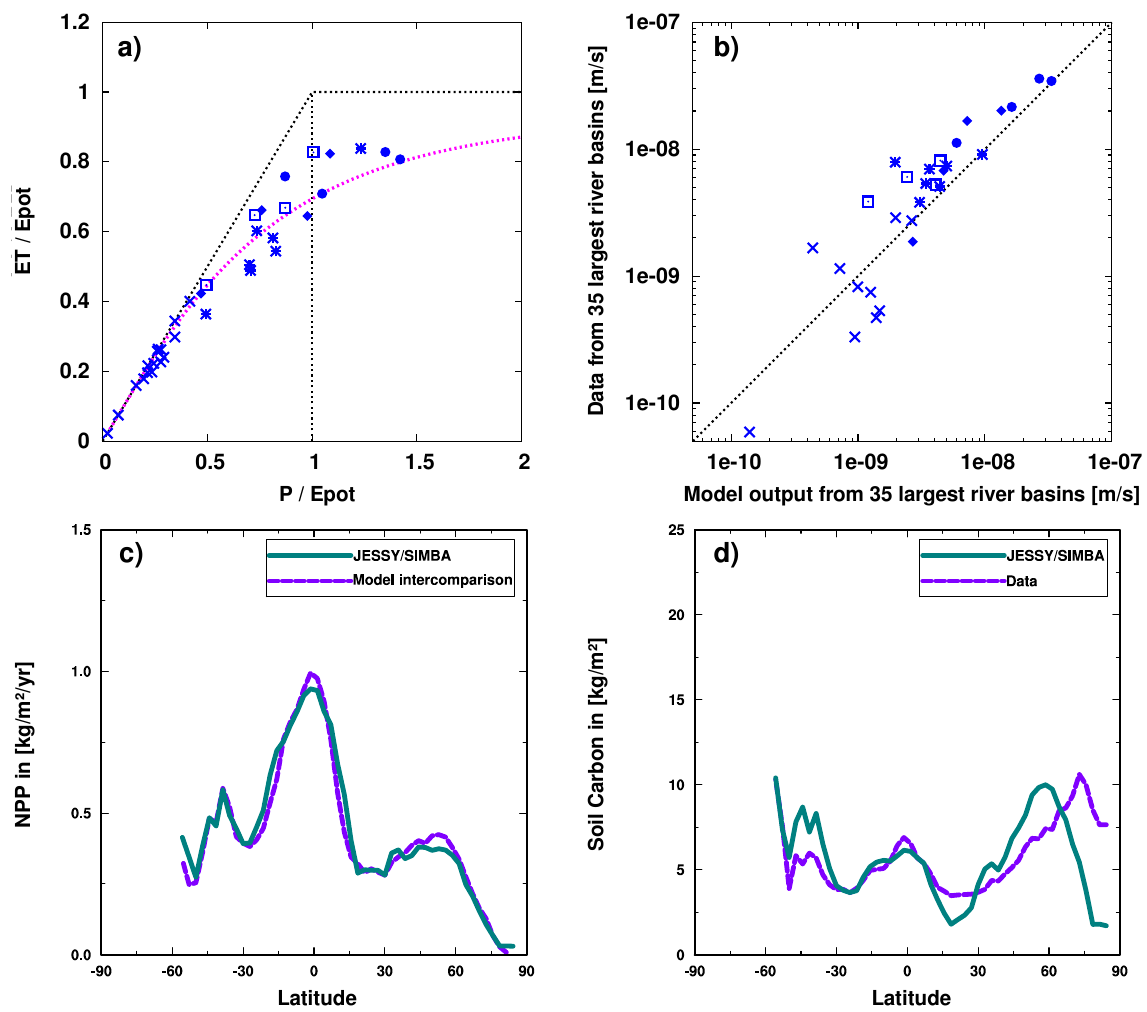
Fig. 5. (a) Modelled evapotranspiration averaged over a basin plotted against the theoretical Budyko-curve (magenta, dashed) for the 35 world’s largest river basins. (b) Scatterplot of modelled runoff and measured runoff for the 35 largest river basins of the world. • corre- sponds to humid tropical, (cid:7) humid subtropical, (cid:0) temperate, > cold continental and × (semi) arid climate regions. (c) Latitudinal pattern of modelled NPP (blue, solid) and the mean NPP of 17 global vegetation models (magenta, dashed) latitudinal pattern of modelled (blue, solid) and measured soil carbon (magenta, dashed), both accumulated over the first meter of the soil. All shown model estimates are derived from a MEP-based parametrisation. They are average values over the last 10 yr of a simulation.